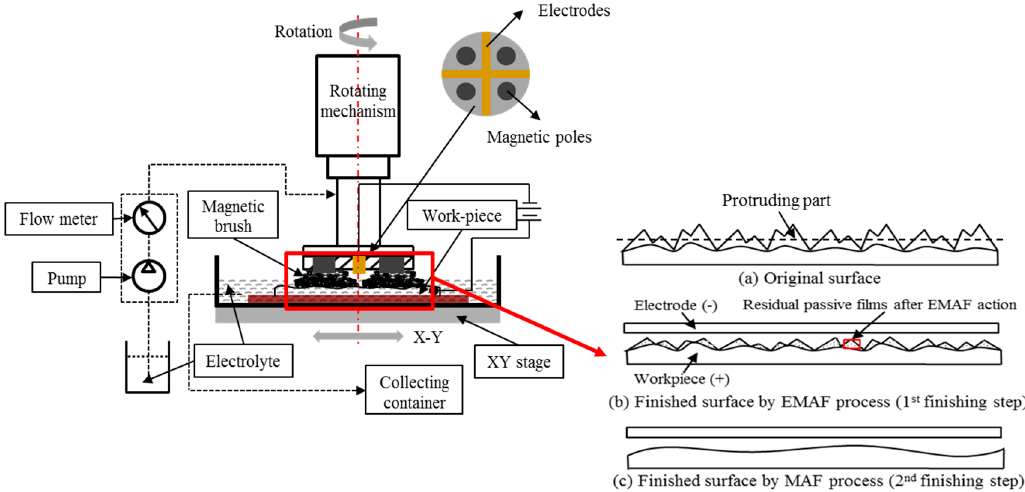
Figure 1. Schematic of the electrolytic/electrochemical magnetic abrasive finishing (EMAF) process.